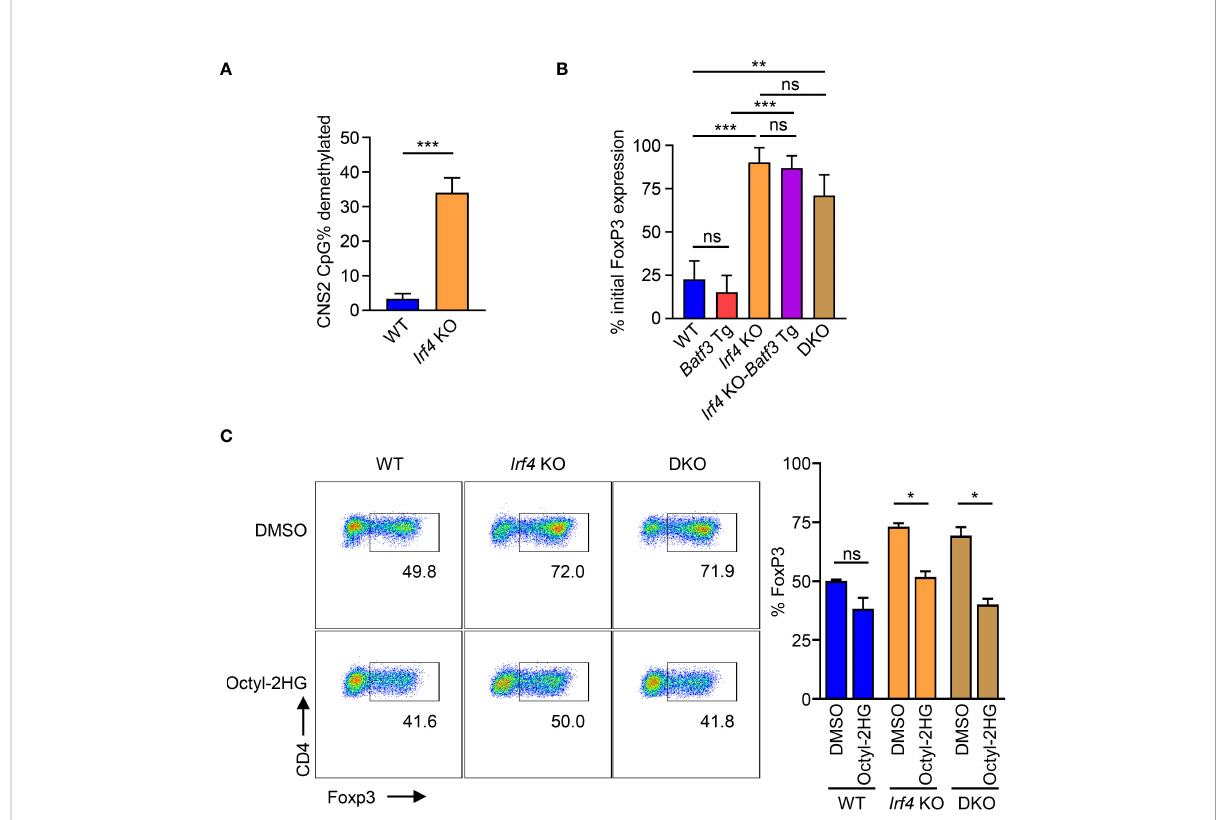
FIGURE 5 Control of FOXP3 expression through CNS2 methylation. (A) % CpG demethylation of the CNS2 Foxp3 enhancer. Irf4 KO and WT CD4+ T cells were activated and differentiated for 72 hrs in iTreg media before bisul fi te sequencing of the CNS2 region. Data expressed as mean + S.D. of 3 independent experiments. (B) FOXP3 stability: Naïve CD4+ T cells were activated and differentiated for 72 hrs in iTreg media before being reactivated by APCs and recultured for 72 hrs in T 0 media. Data expressed as mean and S.D. of % of FOXP3 expression before reactivation by APC. n=3. ( (C) ) FOXP3 expression of cells activated and differentiated for 72 hrs in iTreg media in the presence of 0.5 mM Octyl-2HG or DMSO vehicle control. Data expressed as mean + S.D of 2 independent experiments. Statistical signi fi cance determined by unpaired two-tailed Student ’ s T test. *p<0.05, **p<0.01, ***p<0.001, ns, not signi fi cant